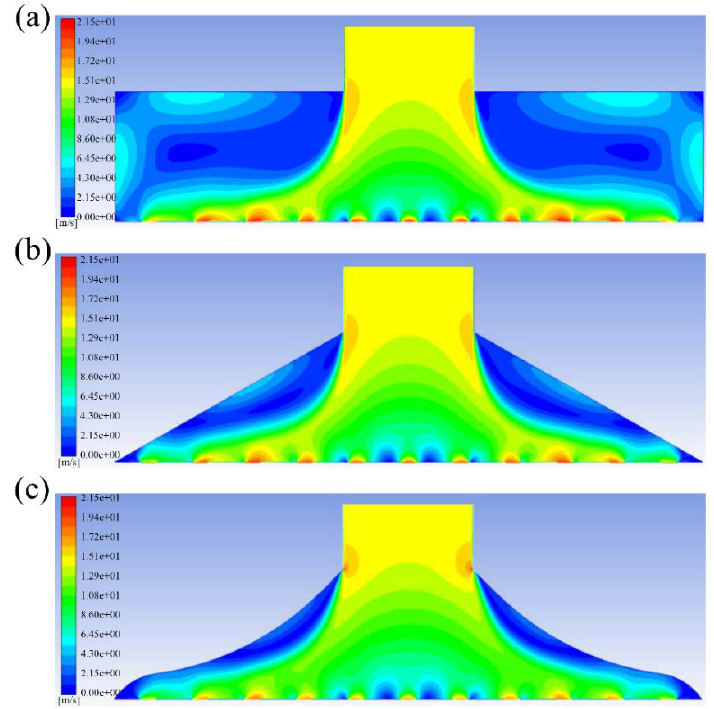
Figure 7. Velocity contours in the inlet header: ( a ) Direct transition duct; ( b ) triangle transition duct; ( c ) quasi-parabola transition duct.